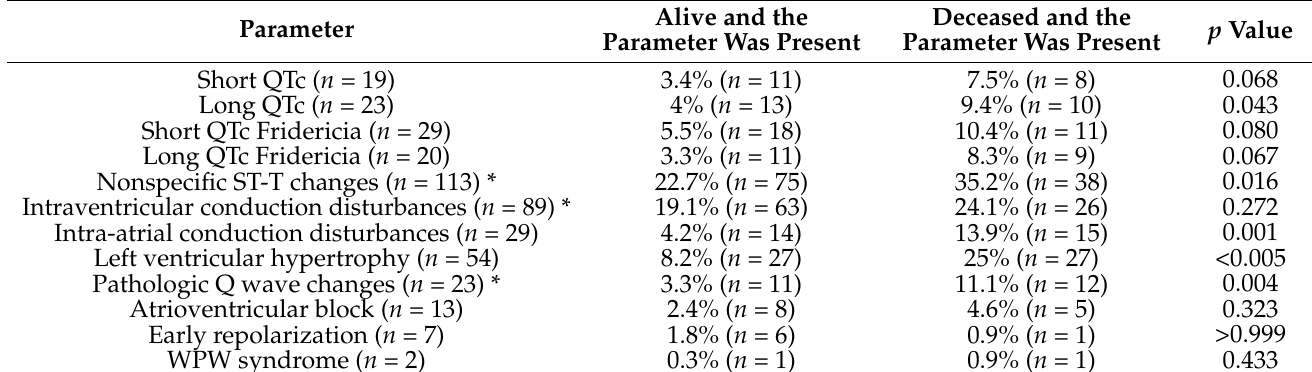
Table 1. Electrocardiographic parameters in the study population ( n =